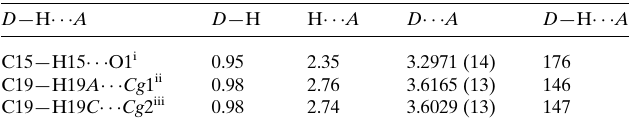
Figure 7 Fragment of the crystal structure of (I), showing part of a [010] chain linked by C15—H15 (cid:3)(cid:3)(cid:3) O1 hydrogen bonds. [Symmetry codes: (i) x , y (cid:6) 1, z ; (ii) x , y + 1, z .]